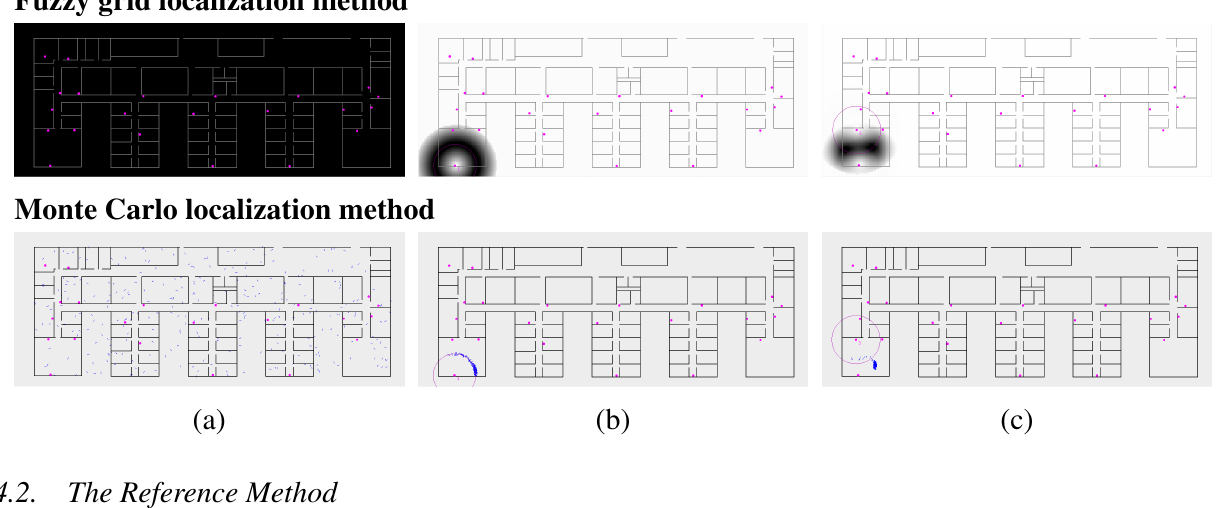
Figure 4. Example of sensor model and update phase of the fuzzy grid (upper) and Monte Carlo (lower) localization